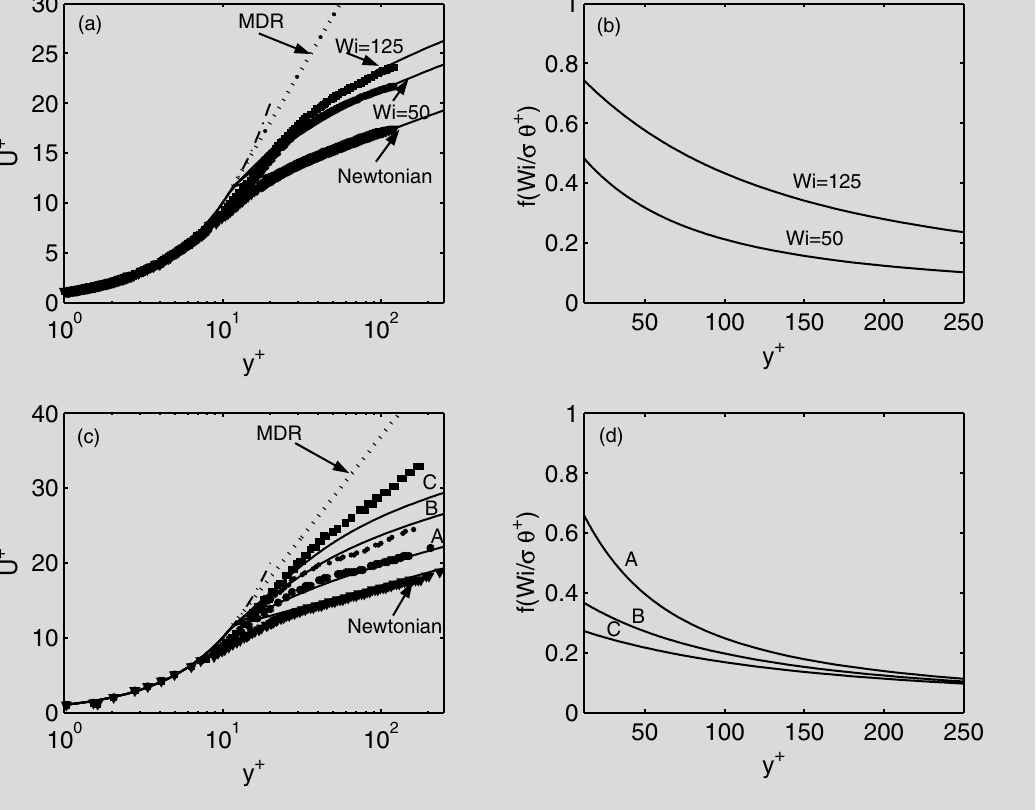
Figure 7: Comparison of mean velocity profiles from the phenomenological model (symbols in a & c) with DNS results (lines in a & c) from [21] and [28]. The model parameter obtained by best overall fit to these data is s = 0.22. In (a) and (b) above, Tr = 180. In (c) and